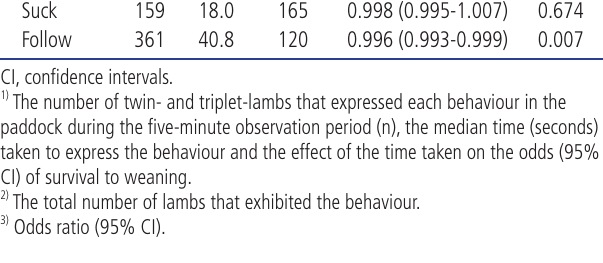
Table 3. Twin and triplet lamb behaviours observed 3 to 18 hours after birth 1)